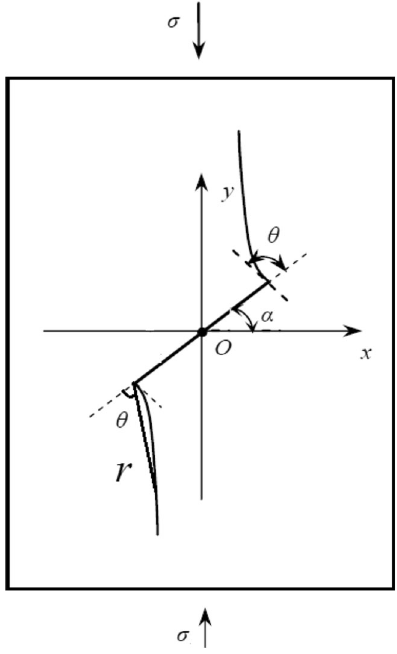
Fig. 1 Inclined crack propagation